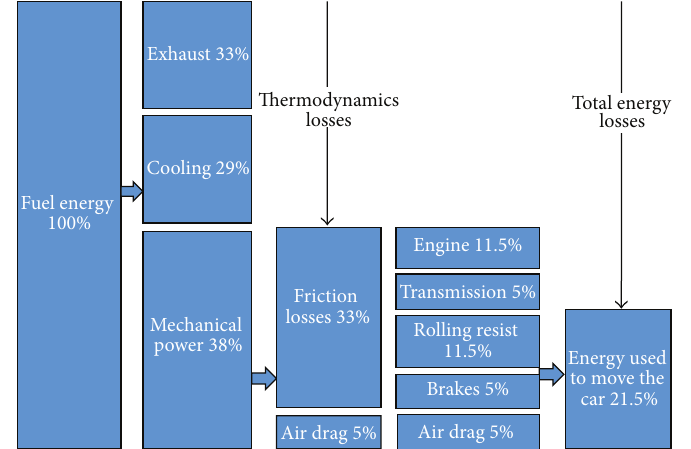
Figure 1: Energy losses of internal combustion engine.